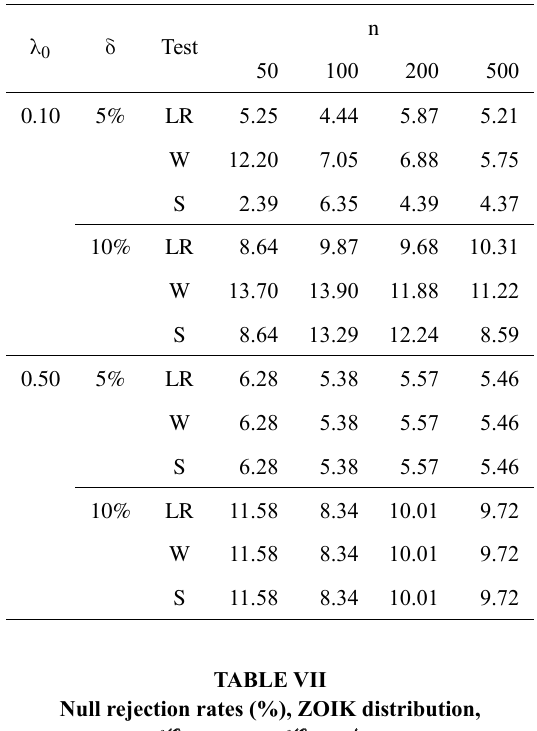
Null rejection rates (%), IK 1 distribution, H